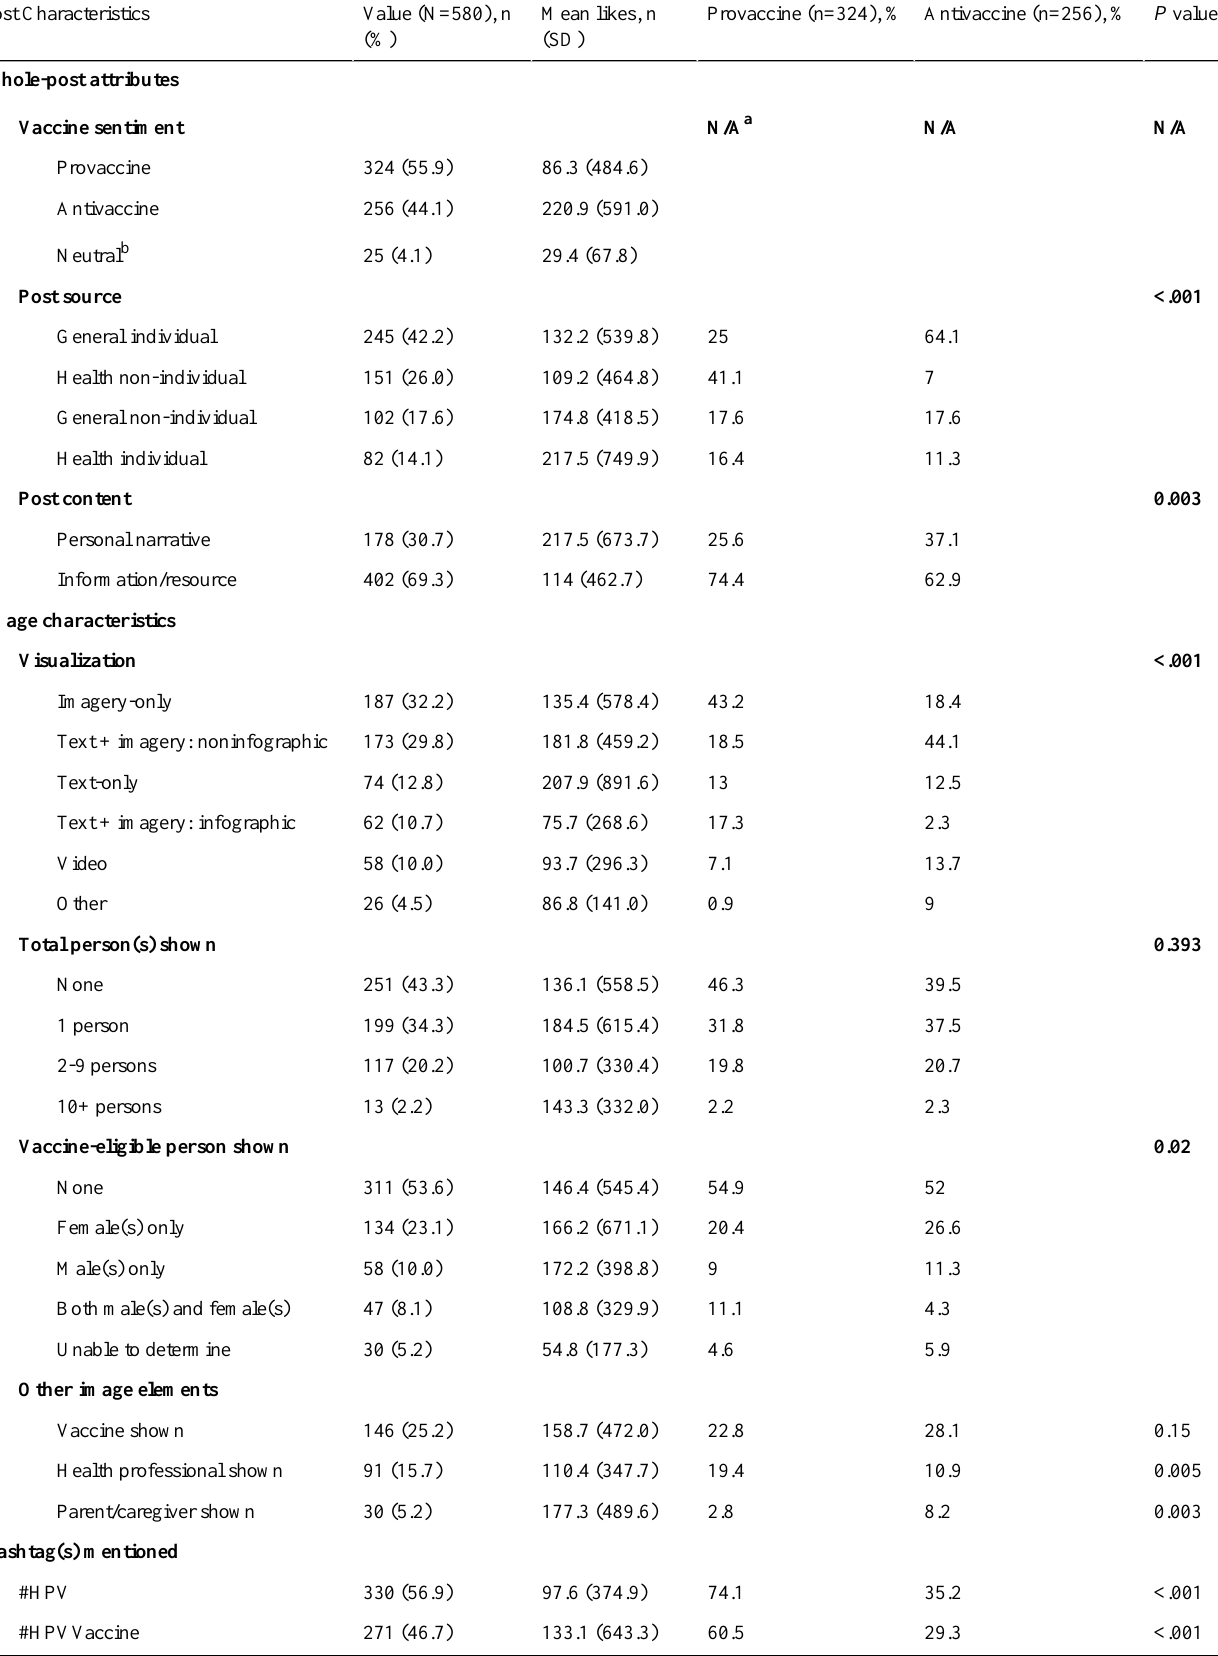
Table 1. Frequency and proportion of Instagram post characteristics (ie, image, text, and social media features) for pro- and antivaccine posts. Results ordered descending by total frequency. Mean like counts and SDs are provided for all posts. Chi-squared tests assessed significant differences in distribution of post characteristics between pro- and antivaccine posts